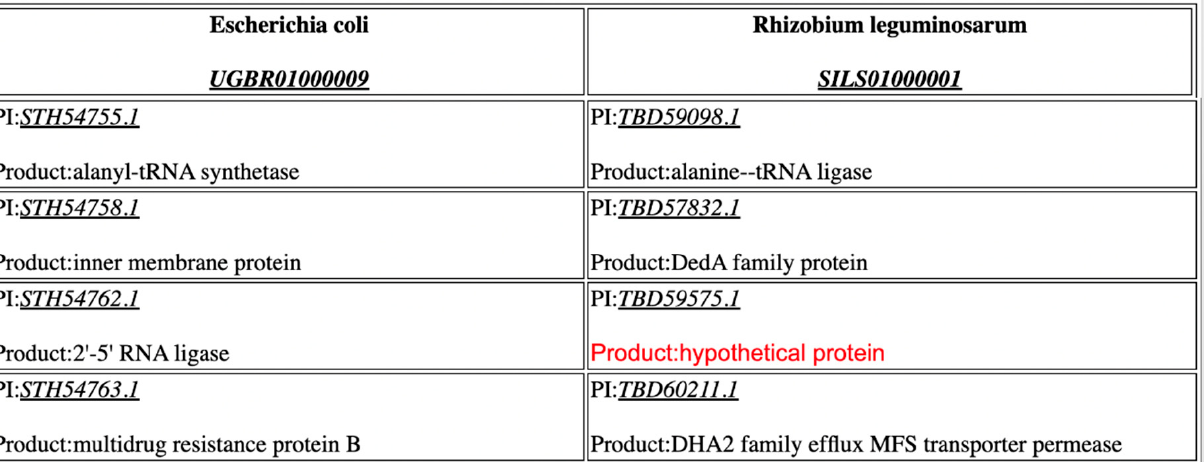
Figure 4. CoreGenes assists in the identification and annotation of hypothetical proteins. Here, the annotated hypothetical protein in Rhizobium leguminosarum , labeled in red, is putatively identified as 2’-5’ RNA ligase in a reference genome, E. coli . Flagging this to the user allows for a subsequent evaluation for identity.